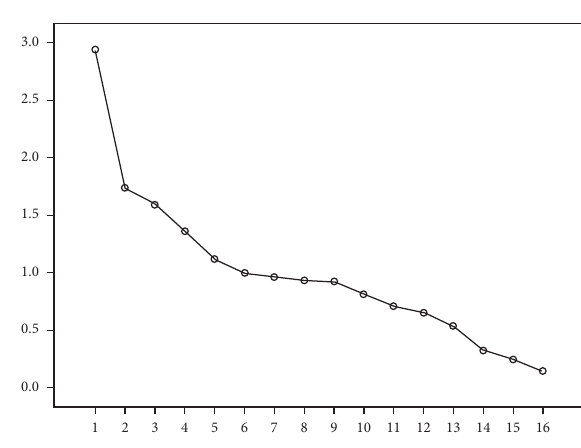
Figure 4: The common factor